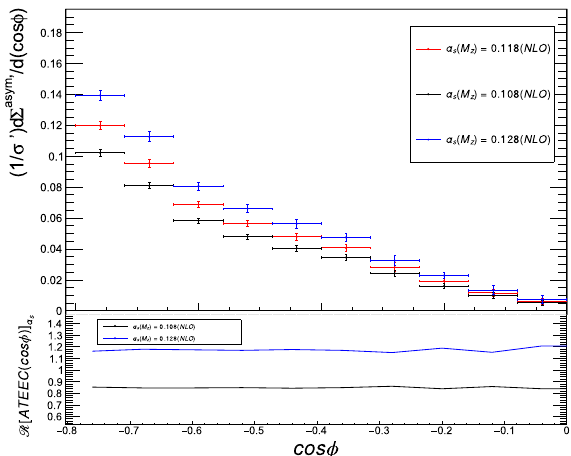
Fig. 8 Upper frames: Dependence of the differential distribution 1 /σ (cid:7) d (cid:9) (cid:7) / d ( cos φ) (left) and its asymmetry 1 /σ (cid:7) d (cid:9) (cid:7) asym / d ( cos φ) (right) on the QCD coupling constant α s ( M 2 cated values of α s ( M 2